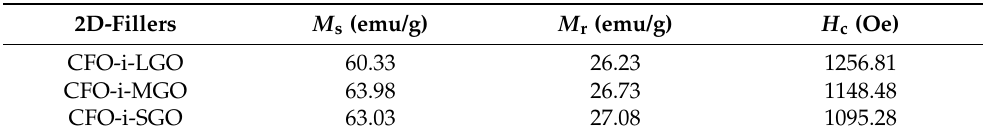
Table 2. Magnetic properties in the 2D magnetostrictive fillers of CFO-i-LGO, CFO-i-MGO, and CFO-i-SGO confirmed by vibrating sample magnetometer (VSM) measurement.